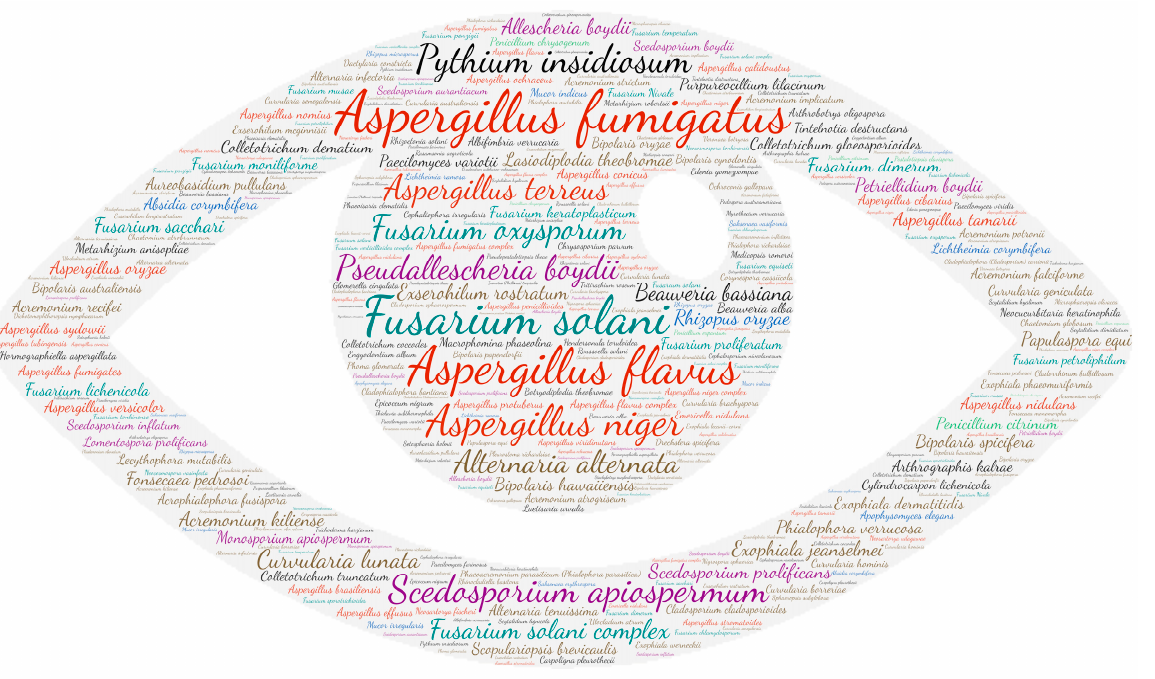
Figure 4. Wordcloud represents the species name isolated in the ocular system. The size of the name of each species is proportional to the number of times it occurs in the repertoire.